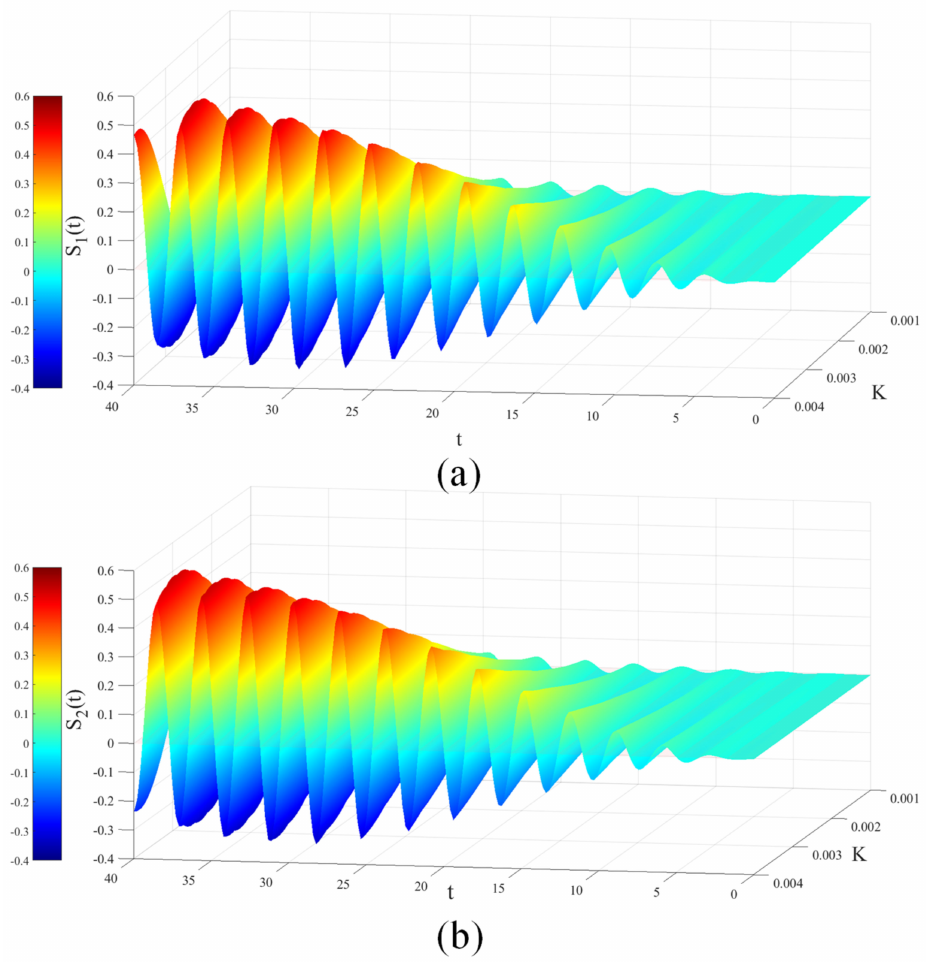
Figure 2. The squeezing coefficients S i ( t ) as a function of K and t , where K is dimensionless in units of ω , g = 10 K , α a = 4 and α m = 2. ( a ) S 1 ( t ) = S 1 m ( t ) / | α a | 2 , ( b ) S 2 ( t ) = S 2 m ( t ) / | α a | 2